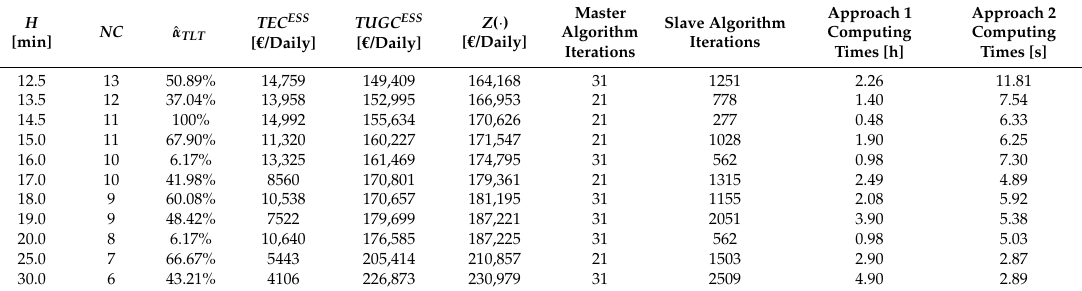
Table 10. Solution algorithm performance in the case of 97.5th percentile.